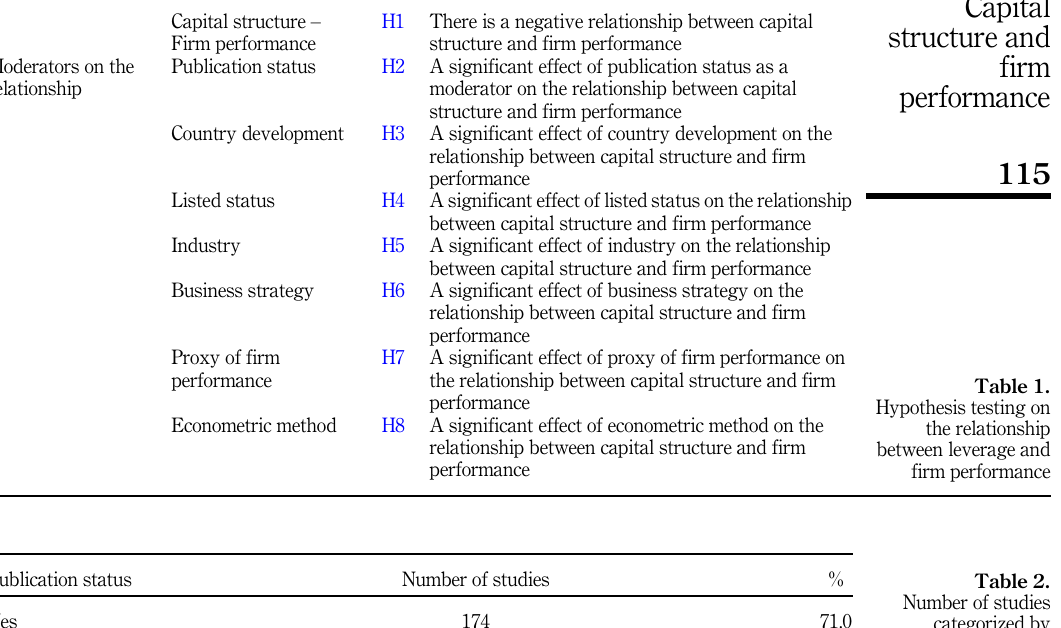
Table 2. Number of